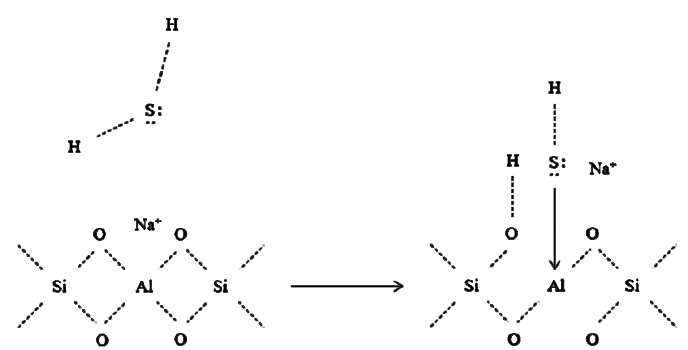
Figure 2. Dissociative H 2 S adsorption on an aluminosilicate zeolite (adopted from [40]).